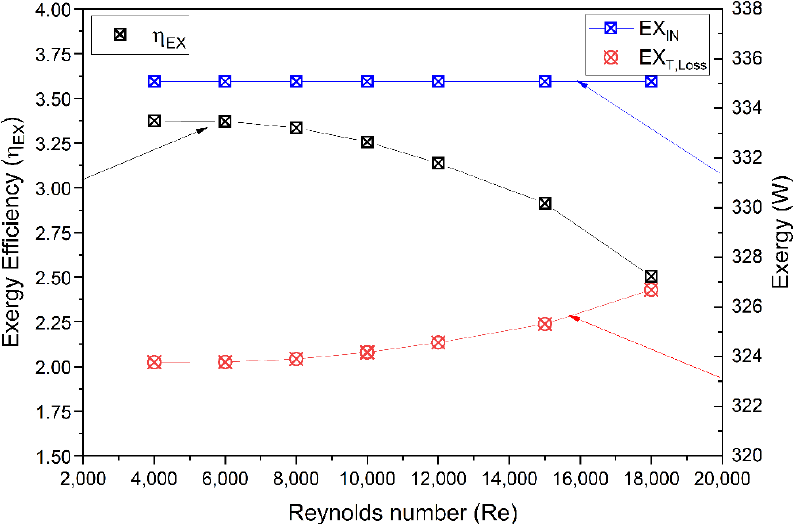
Figure 16. Total exergy inlet, exergy losses and the exergy efficiency for varying Re values.